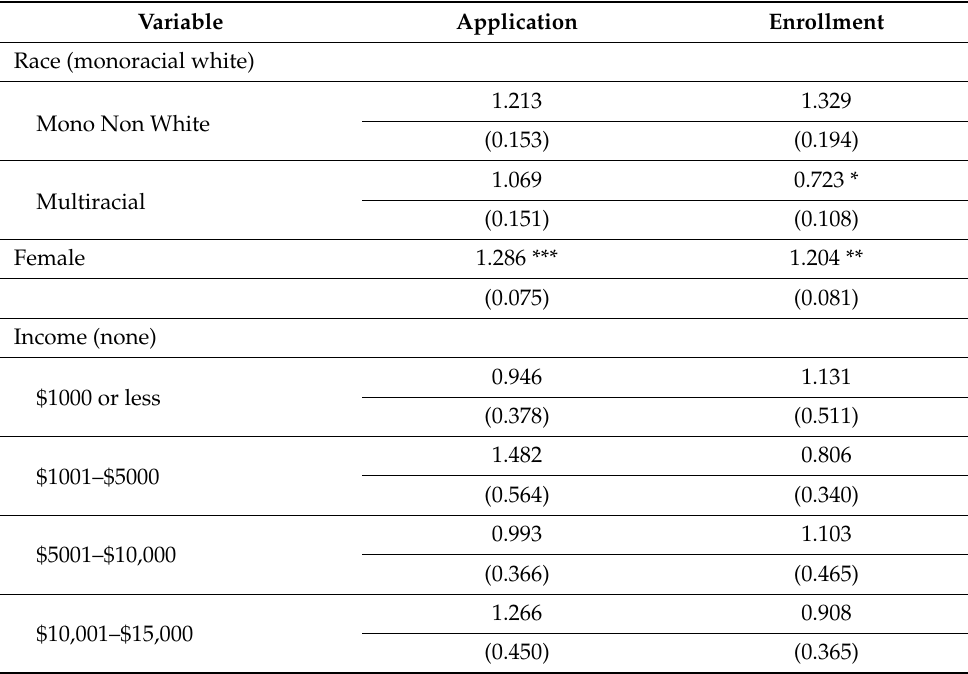
Table A1. Logistic Regression of Application and